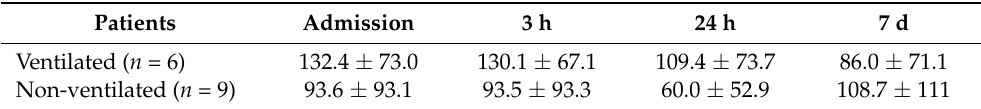
Figure 2. cDPP3 values within the first week in the ICU in ventilated and non-ventilated patients. At all timepoints, ventilated patients have significantly higher cDPP3 values compared to non-ventilated patients. Adm, admission to ICU. Table 2. cDPP3 values (in ng/mL) in ventilated and non-ventilated patients. The data are reported as mean ± standard